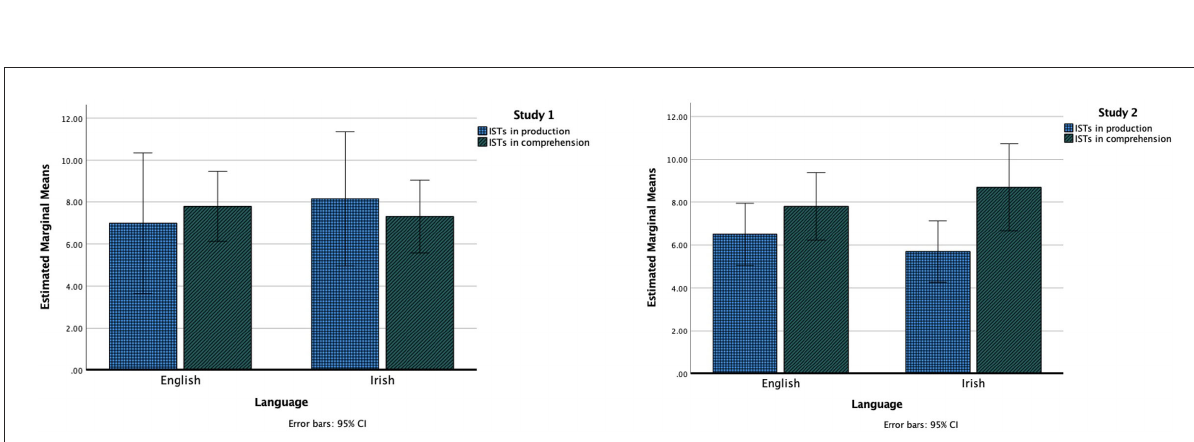
the language. No significant interaction was found between language and output type [ F (1,19) = 0.159, p = 0.70, η 2